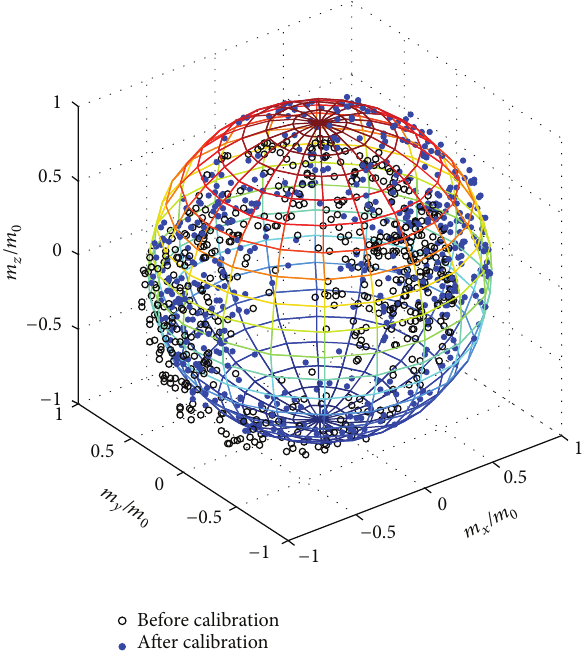
Figure 3: 3D locus of magnetometer outputs. magnetometer outputs coincides well with the unit sphere, demonstrating the effectiveness of the calibration